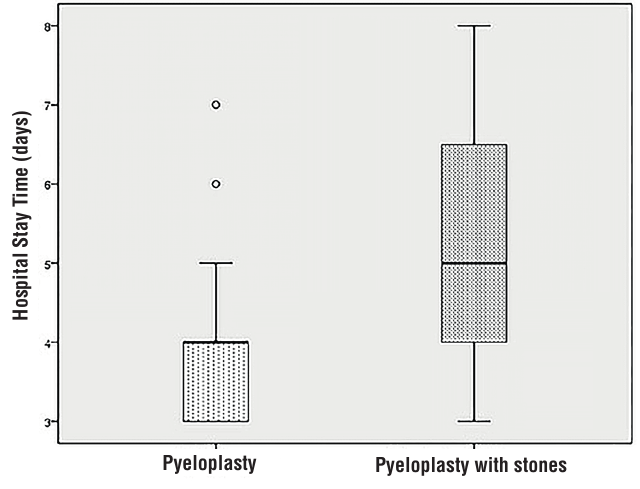
Figure 1 - Distribution of postoperative duration of hospital stay between laparoscopic pyeloplasty and laparoscopic pyeloplasty with